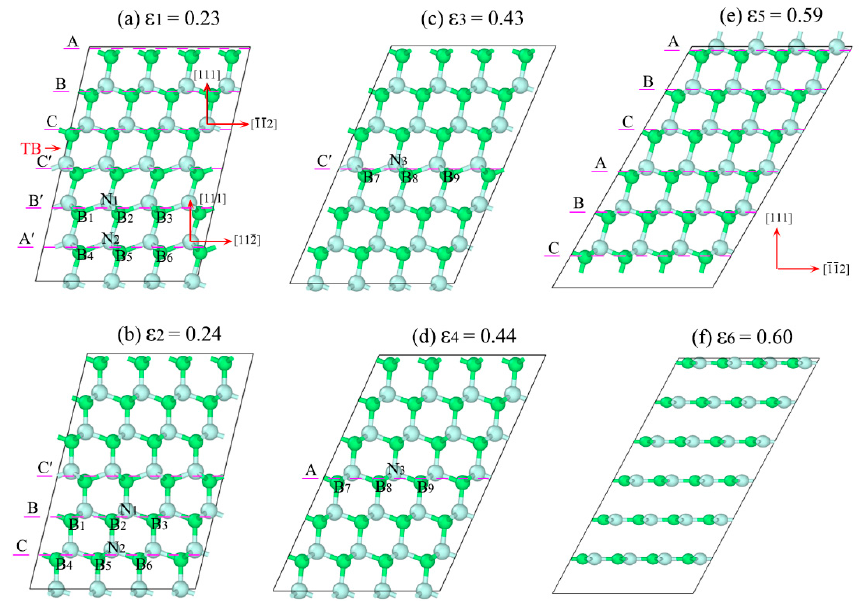
Figure 6. ( a ) to ( f ) are typical atomic configurations of nt-cBN sheared along (111) [112] easy shear direction during 0.23 ≤ ε ≤ 0.60, respectively, with upper and lower halves corresponding to easy- and hard-shear directions in ( a ).